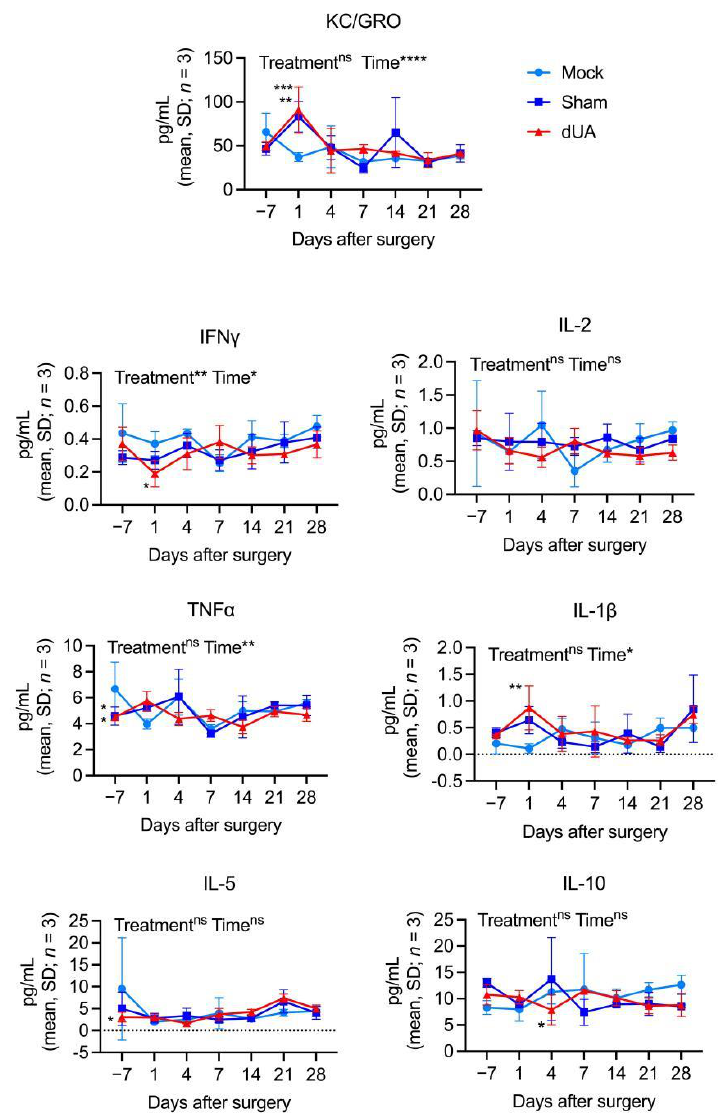
Figure 2. Systemic cytokine levels in mice implanted with human dUA. Cytokine levels were measured 7 days before and at 1, 4, 7, 14, 21, and 28 days after dUA implantation in mice. Each group (mock, sham or dUA) consists of three measurements of randomly pooled plasma from two to four mice from the same group ( n = 3, n * = 2–4). The effect of treatment (mock, sham and dUA) and time after surgery were analysed by two-way ANOVA (post-test: Tukey test) for statistics. * p ≤ 0.05, ** p ≤ 0.01, *** p ≤ 0.001, **** p ≤ 0.0001, ns p > 0.05.